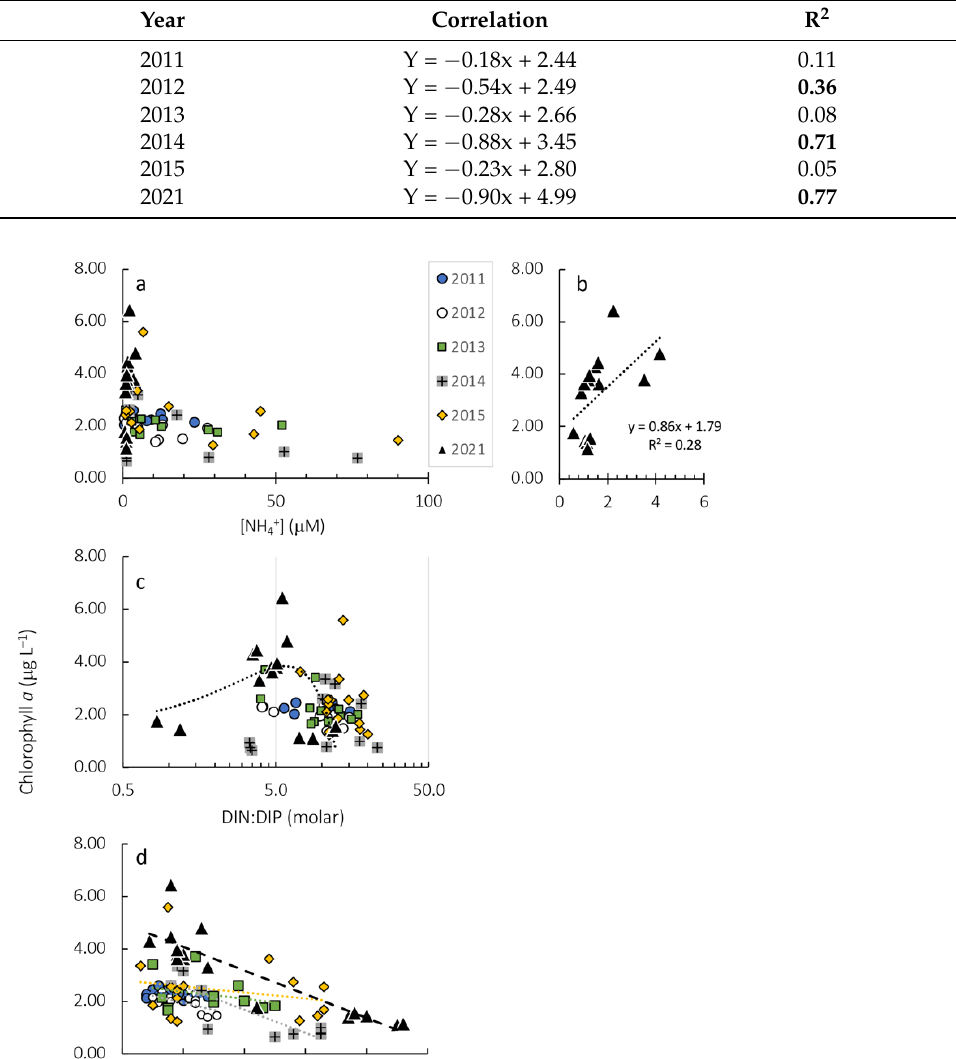
Table 1. Correlations between chlorophyll a and Secchi depth. Relationships for 2012, 2014 and 2021 were significant at p < 0.05 (as indicated by bold font).